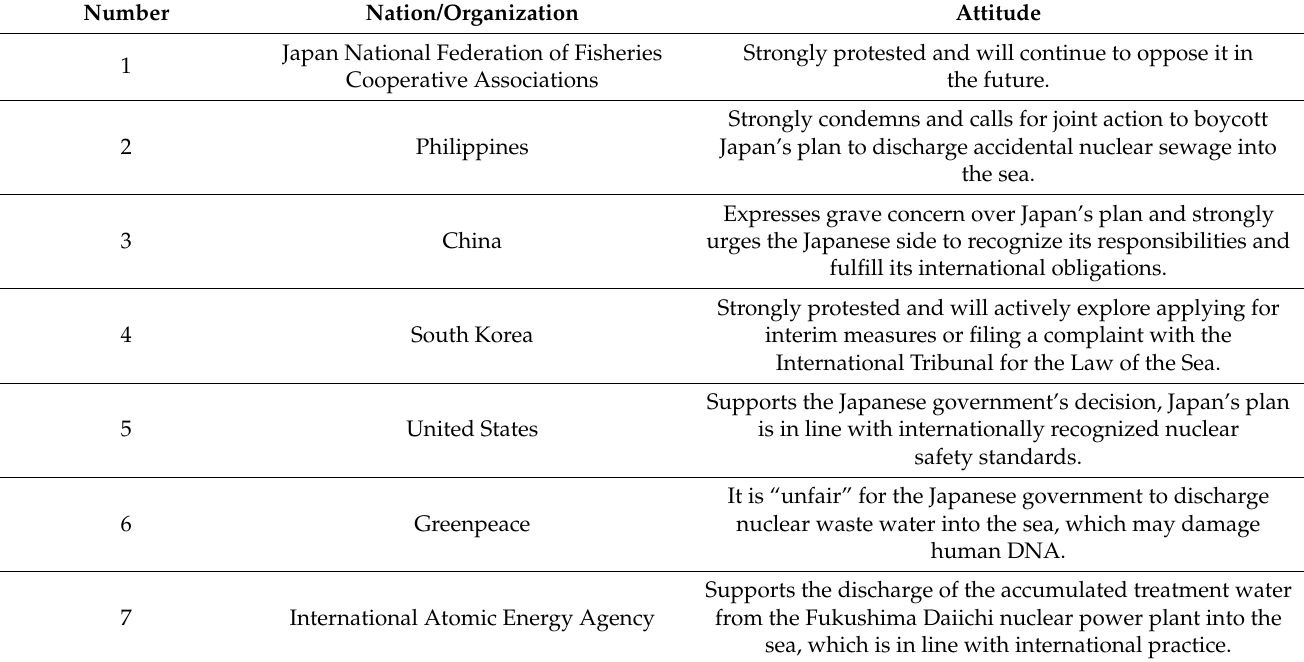
Table 1. Attitudes of related industries and neighboring countries that may be